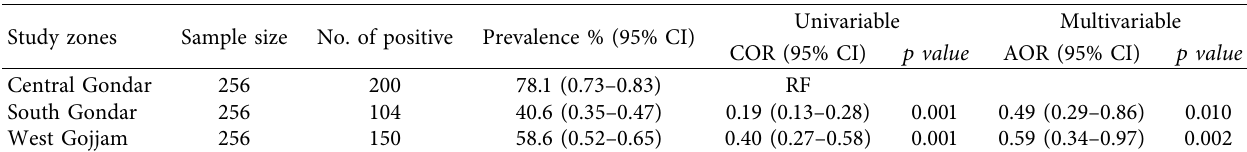
Table 4: Univariable and multivariable analysis of seroprevalence in relation to study